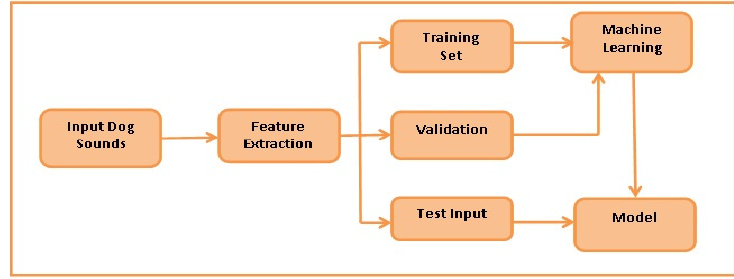
Figure 5. Training process of dog sounds.